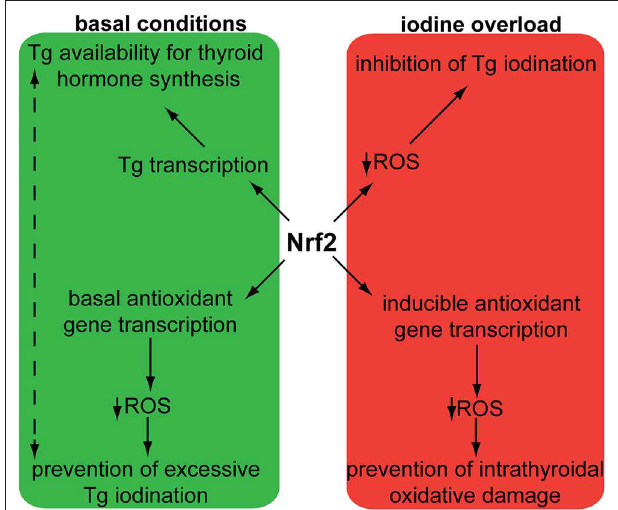
FIGURE 2 | Schematic representation of demonstrated and proposed pleiotropic functions of Nrf2 in follicular thyroid cells under basal conditions and in response to iodine overload. The solid arrows indicate mechanisms that have been sufficiently demonstrated experimentally. Nrf2: nuclear factor erythroid 2-related transcription factor 2; ROS: Reactive Oxygen Species; Tg: thyroglobulin. The dotted arrows indicate putative mechanisms that require further investigation. Originally published in Ziros et al. (16); used here with permission from Mary Ann Liebert